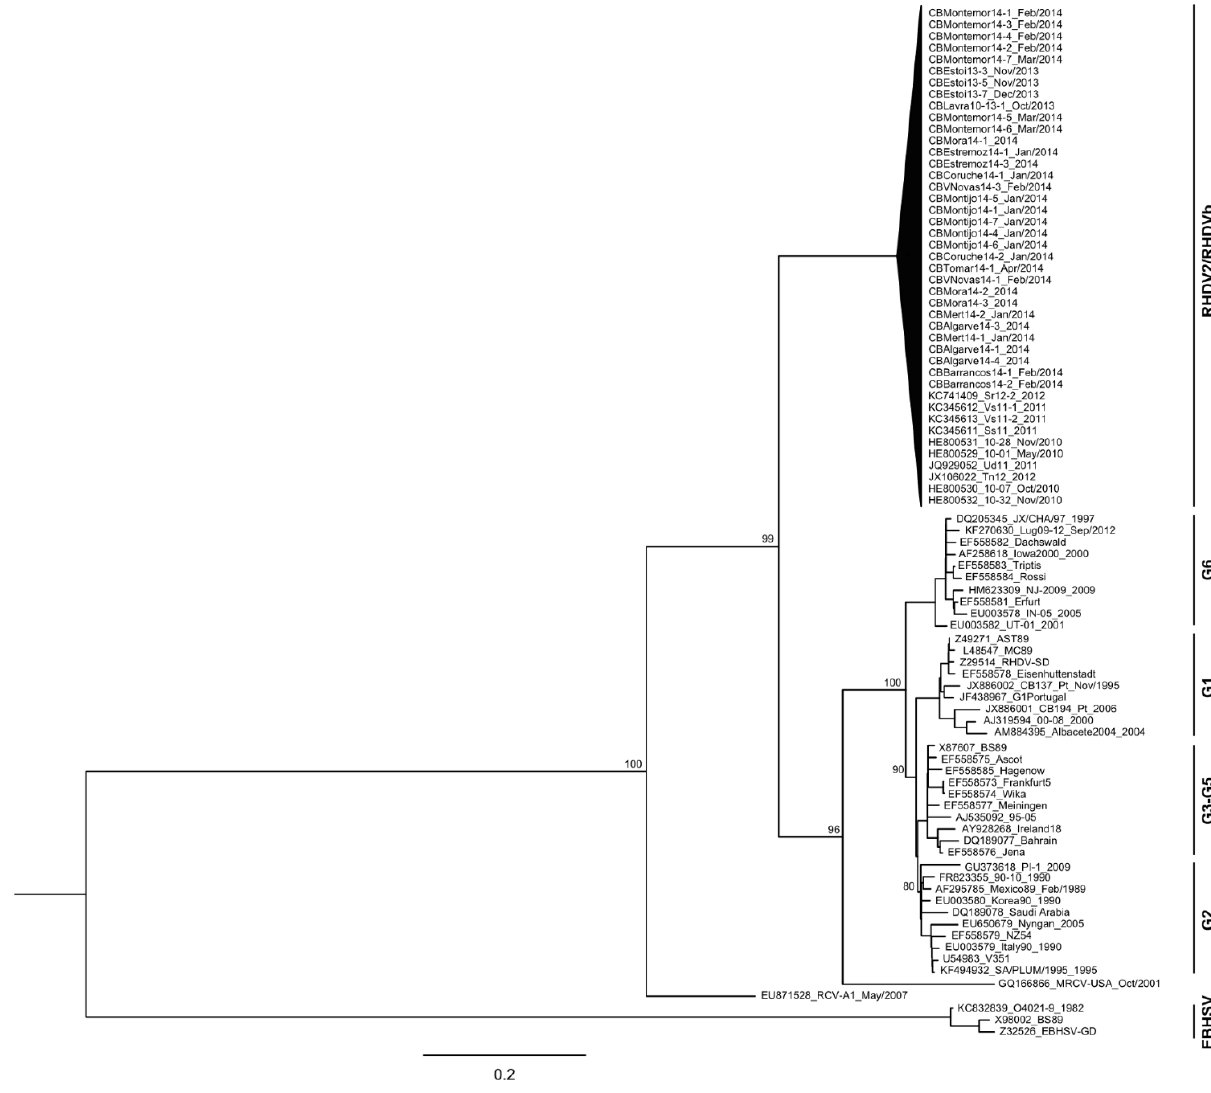
Figure 3. Maximum Likelihood tree of the capsid gene. Bootstrap values of the main nodes (≥0.80) are shown next to them. To facilitate visualization, the new variant group is collapsed (previously identified new variant strains have their accession numbers indicated). Samples were named according to the sampling locality, the year of collection and the number of the isolate (cf. Figure 1); when known, month and year of collection are indicated. Scale bar indicates the nucleotide substitutions per site. GenBank accession numbers of the publicly available sequences used in this study are